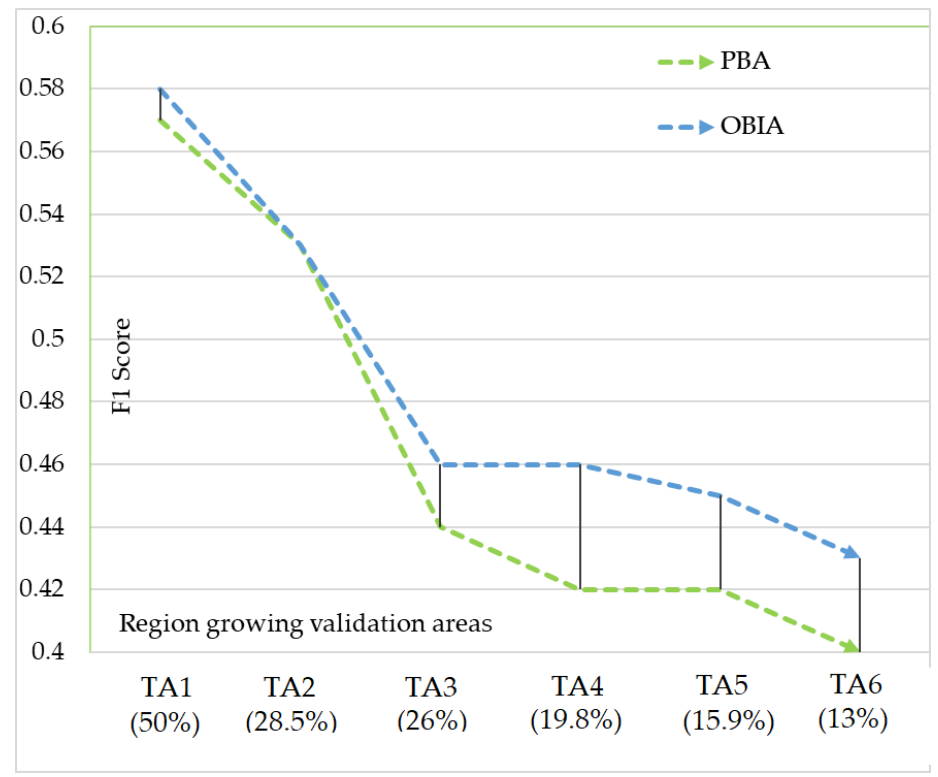
Figure 6. Decrease of the F1 score value for the region growing testing areas (compare with Figure